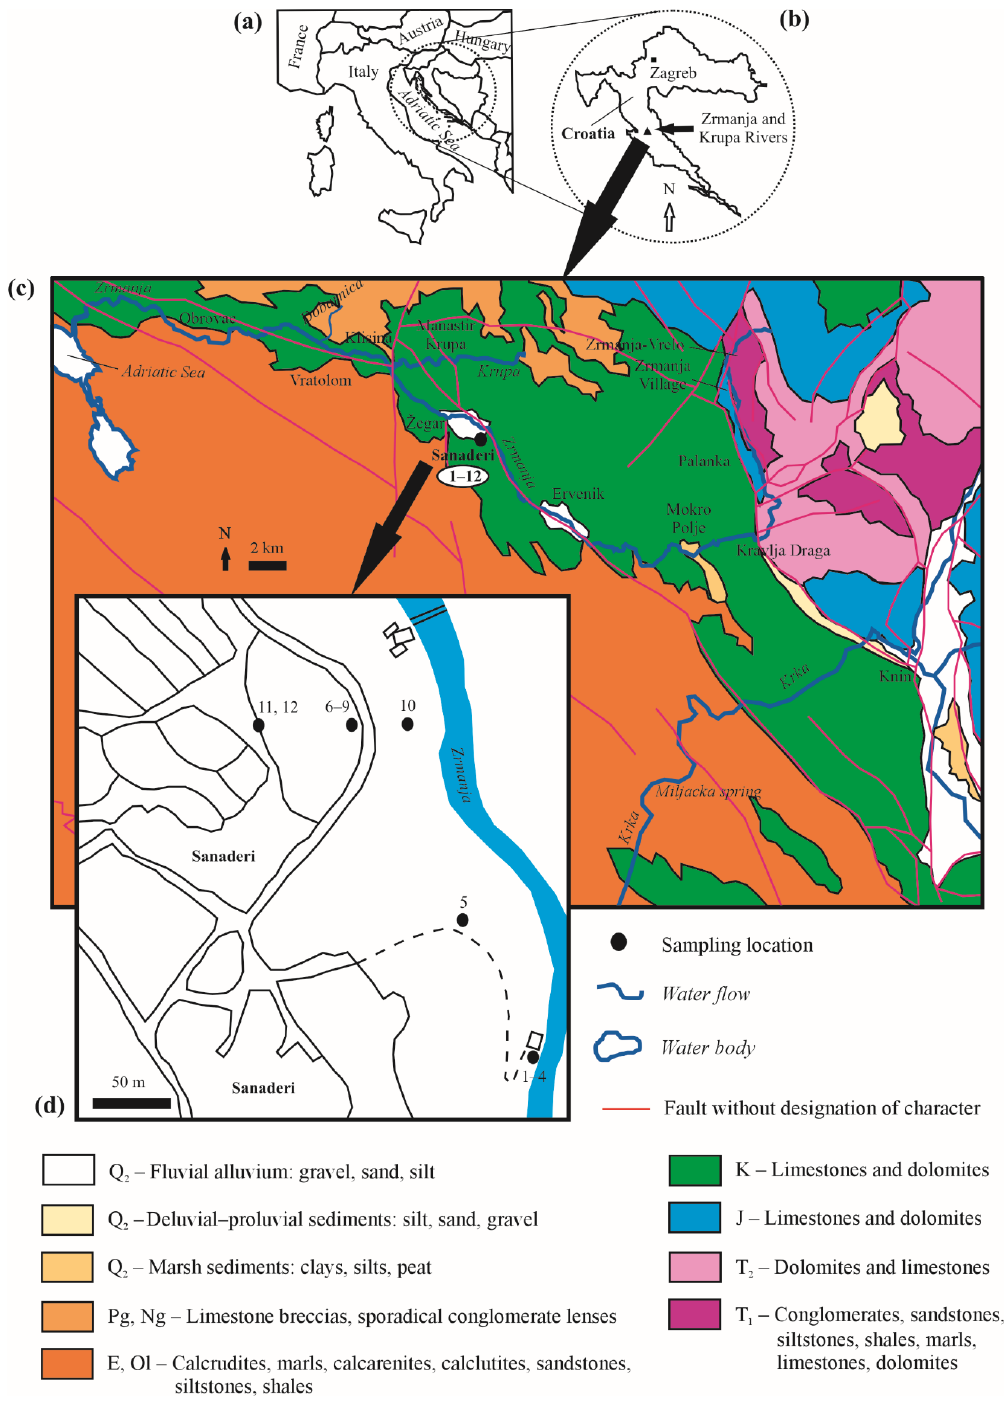
Figure 1. ( a ) Geographical position of Croatia within Europe; ( b ) position of the investigated area within Croatia; ( c ) geolog- ical map of investigated area [50]; for full understanding of this study, Kravlja Draga, where the Zrmanja River changes its course, is also presented as well as the Krka River and Miljacka Spring; ( d ) enlarged area of the Sanaderi location, black dots • mark sampling locations, and the numbers represent tufa sample numbers, see Table 1 for